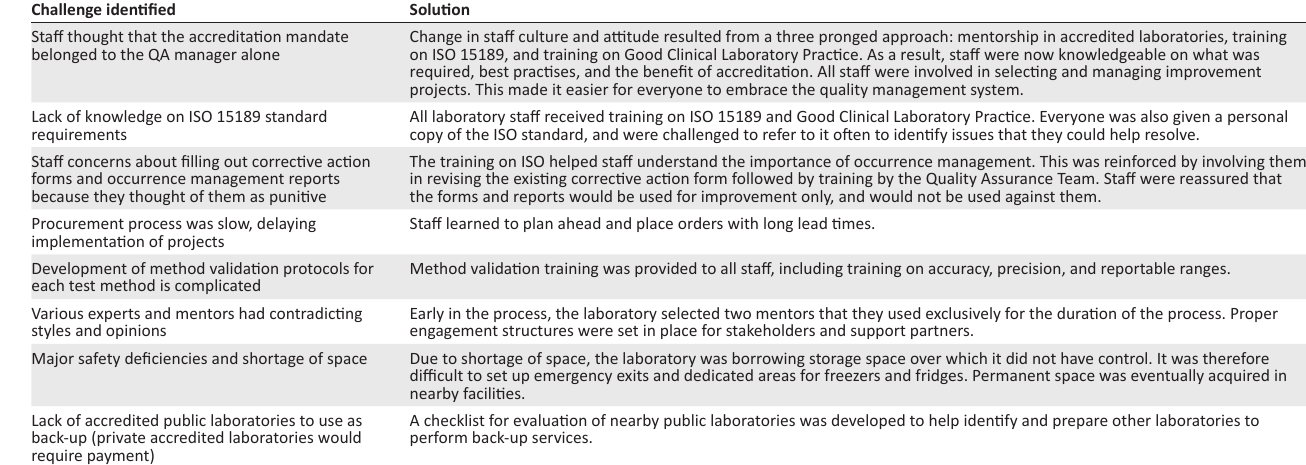
TABLE 4: Challenges and solutions for quality improvement, Kenya’s National HIV Reference Laboratory, 2010–2013. Challenge